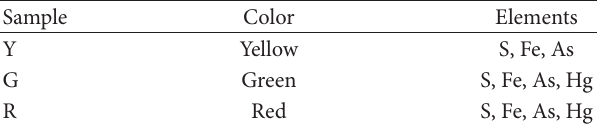
Table 1: Results of surface analysis by